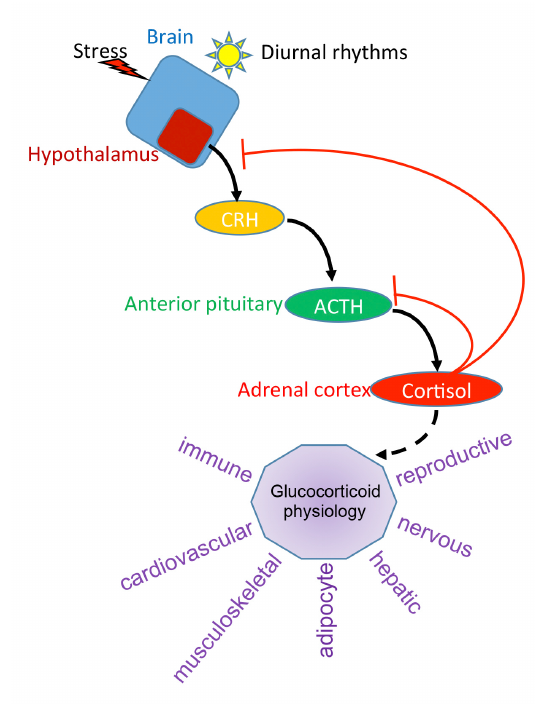
Figure 2. Hypothalamic-pituitary-adrenal (HPA) axis. Shown is a representation of the HPA axis. Light or stress activates the hypothalamus to produce corticotrophin-releasing hormone (CRH). This secreted protein binds to the pituitary gland and induces secretion of adrenocorticotropic hormone (ACTH), which in turn signals the adrenal cortex to produce cortisol. Via a negative feedback loop, cortisol suppresses CRH and ACTH to maintain an optimal, stable level of cortisol in the plasma. In purple are some of the physiological responses affected by